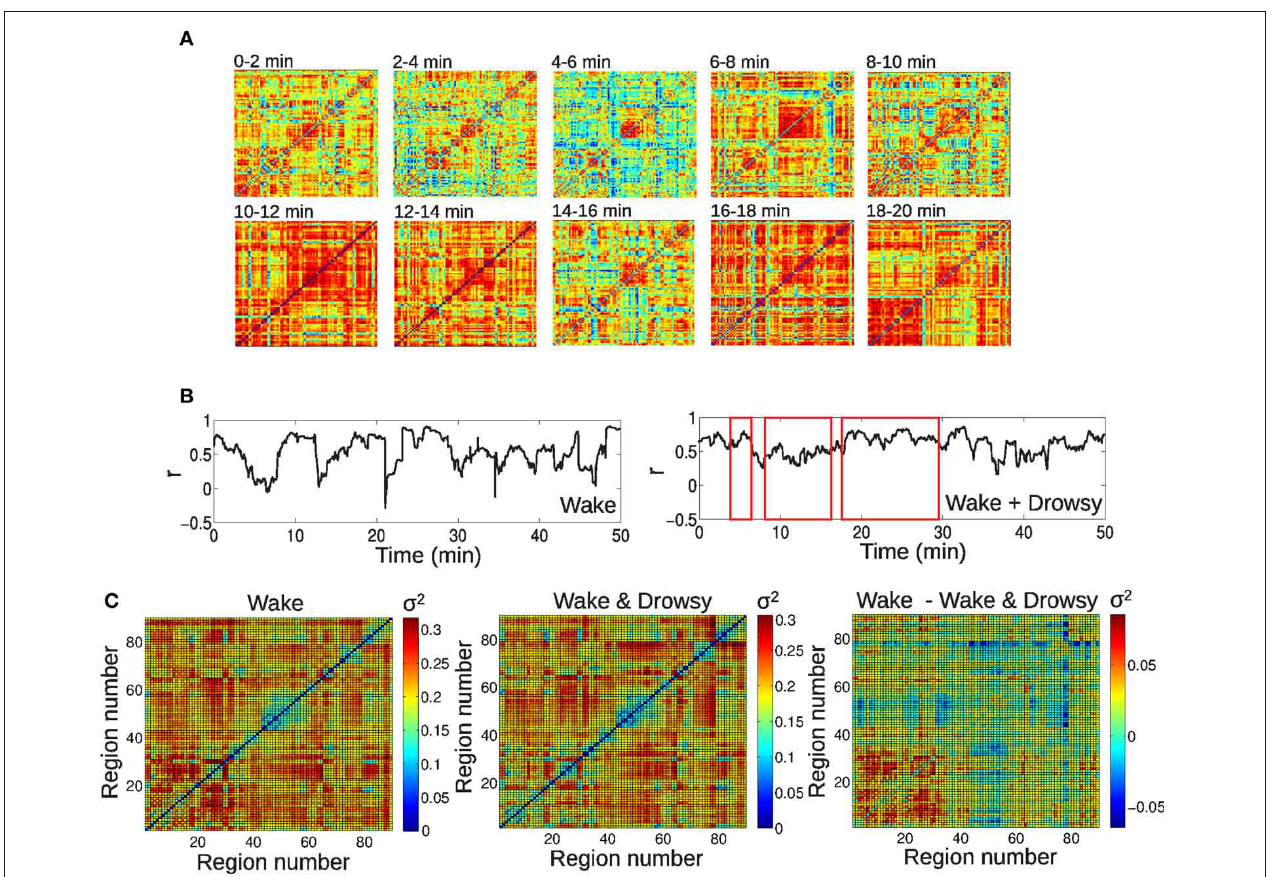
FIGURE 2 | Large-scale spontaneous BOLD functional connectivity fluctuations. (A) BOLD correlation matrices for a single subject, in intervals of 2min. (B) Time series of inter-hemispheric thalamic connectivity for an awake subject and a subject undergoing vigilance transitions between wakefulness